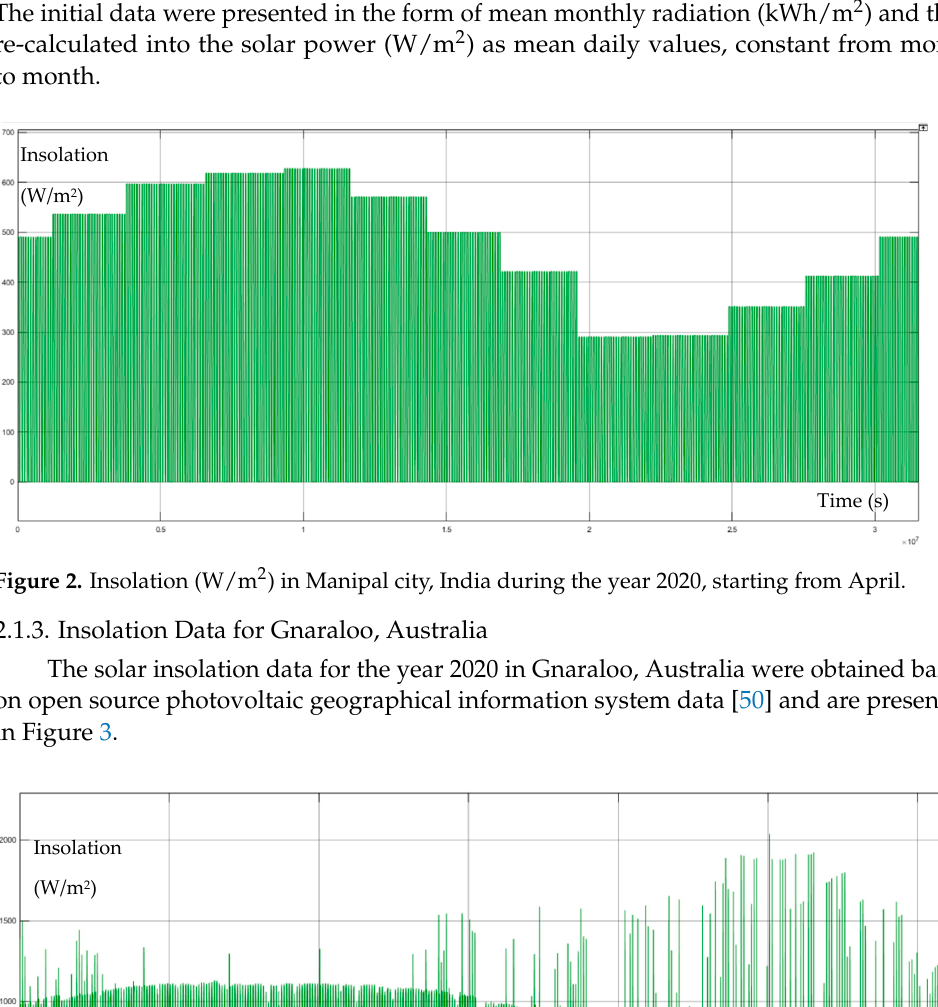
Figure 1. Insolation (W/m 2 ) in Chelyabinsk city, Russia during the year 2020, starting from April.